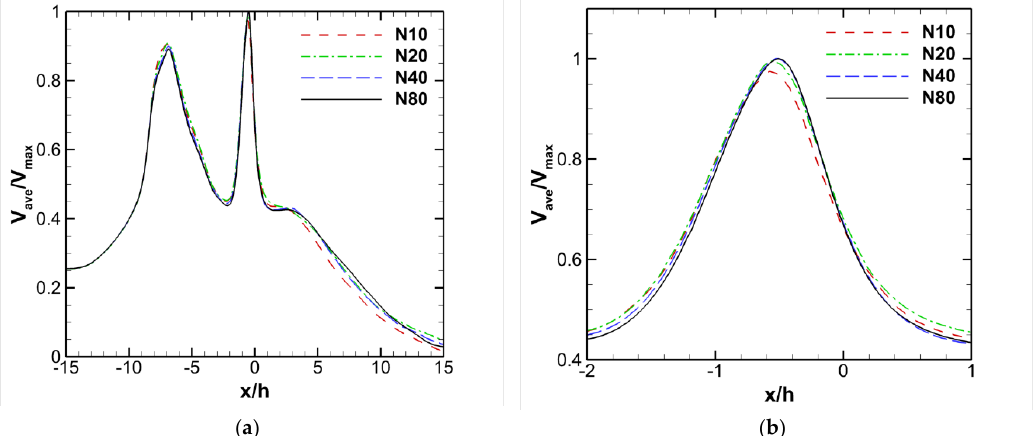
Figure 3. Time-averaged velocity magnitude ( a ) along the SWJ actuator centerline and ( b ) close-up to the SWJ exit nozzle.